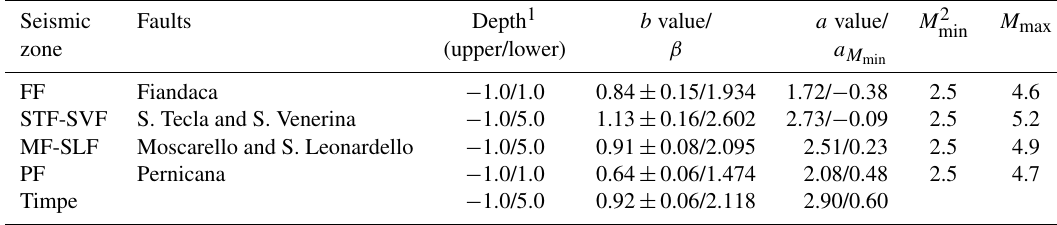
Figure 1. Source typologies at Mt. Etna. (a) Polygonal area sources representing uniform seismicity: the ones defined in this study (in pale blue and yellow) follow the seismogenic sections of the best-known fault systems; in orange is the single area source used in the map of Italian regulation (ZS9, Stucchi et al., 2011). (b) Fault sources modeling the main volcano-tectonic structures detected on Etna’s flanks (see Table 1 for the nomenclature): the red boxes and lines represent the projection at the surface of the fault planes. (c) Three-dimensional mesh of point sources, used to model the scattered background seismicity, with b values represented by colors. Details are given in Part 1 (Azzaro et al., 2017). Table 1. Parameters of area seismic sources used in the final computations. Seismic Faults Depth